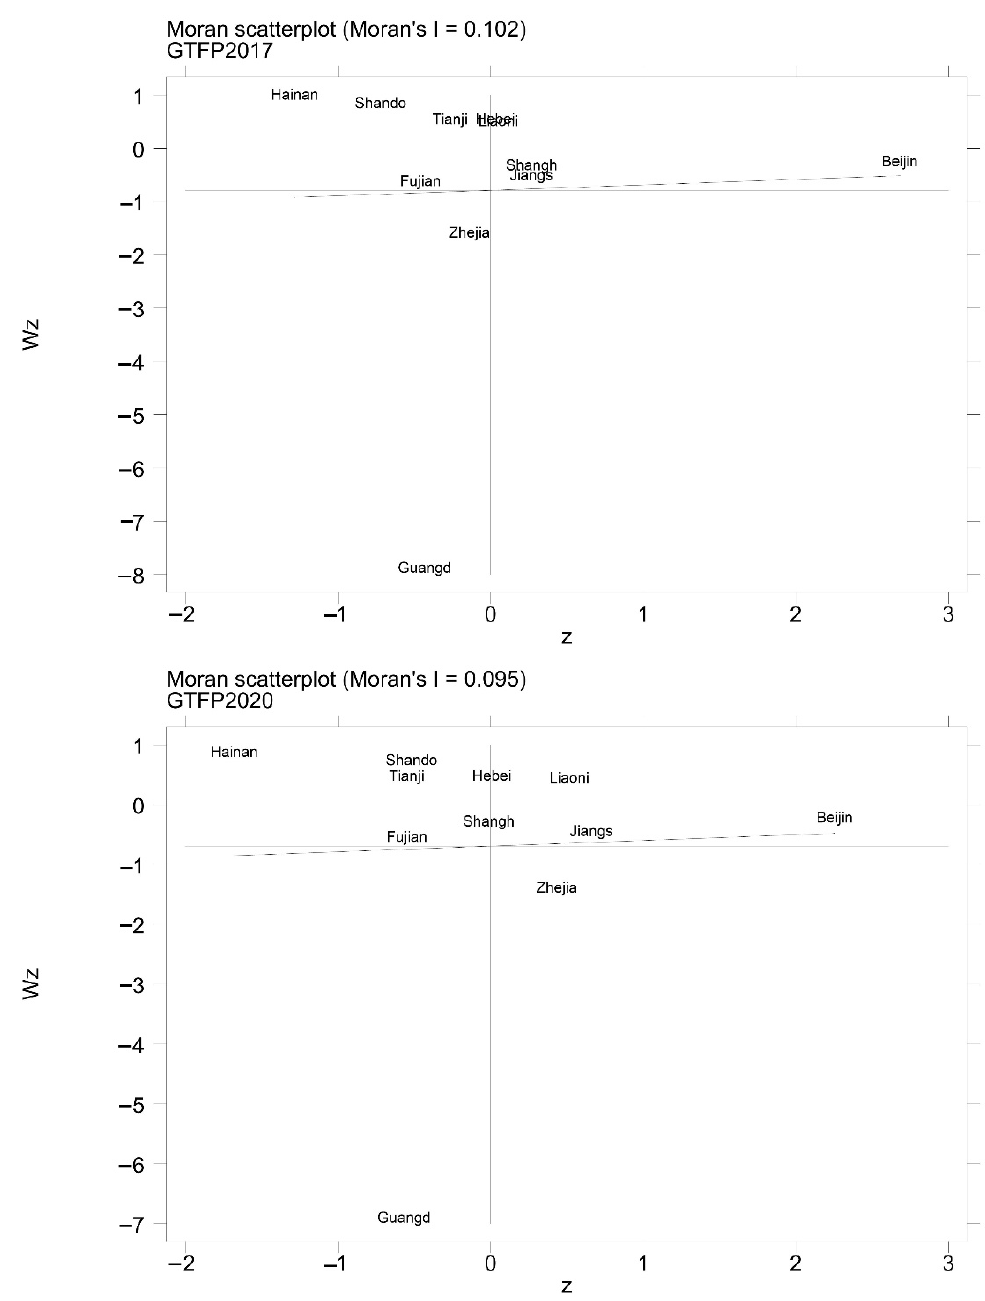
Figure 4. Moran scatter plot—based on MAUP.